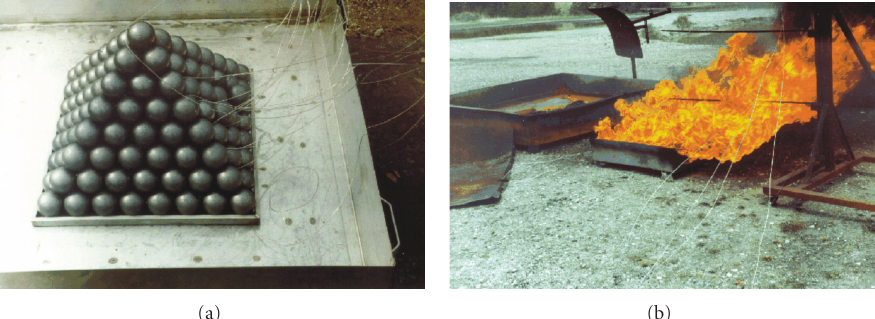
Figure 7: (a) Fuel element arrangement for a kerosene burning experiment. (b) Kerosene burning around the fuel element arrangement of (a).